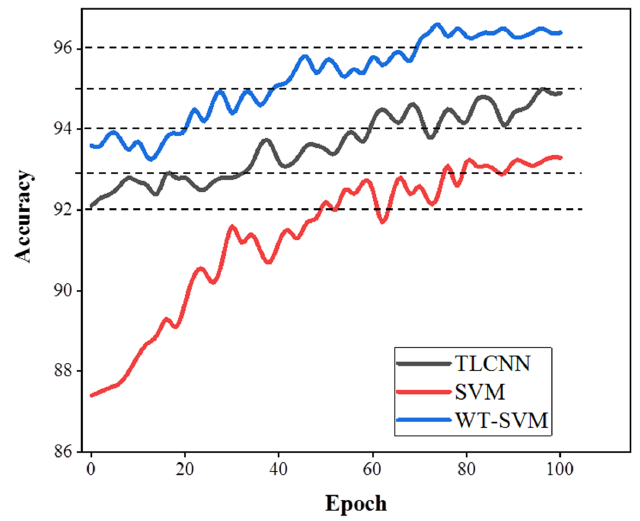
Figure 8. Accuracy comparison of classification algorithms (TLCNN, SVM, WT-SVM).